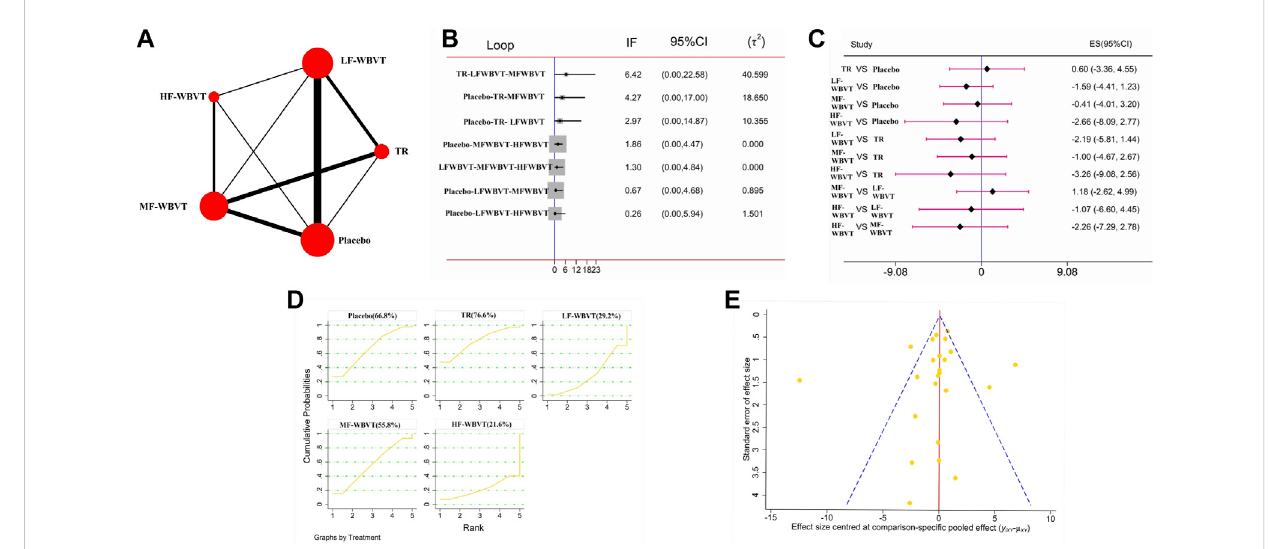
FIGURE 4 Network meta-analysis results for 5STS. (A) Network evidence diagram; (B) loop inconsistency test; (C) Forest plot; (D) The fi gure of Cumulative probability ranking; (E) funnel